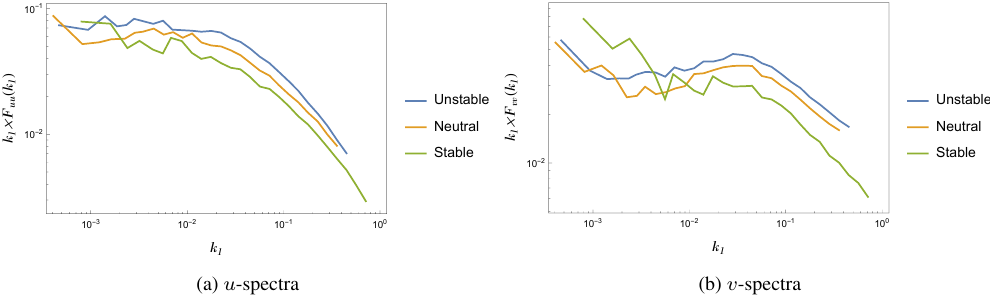
Figure 8. Comparison of the u - and v -spectra derived from high-frequency cup anemometer measurements under different stability conditions to the drag coefficient u ∗ / (cid:104) u (cid:105) . And it is well known that the drag coefficient is larger for unstable stratification. Conse- quently the turbulence scales within the IBL will be smaller as compared to those outside of it. It is then interesting to check whether the WindScanner measures more within the IBL under unstable conditions as compared to the stable con-